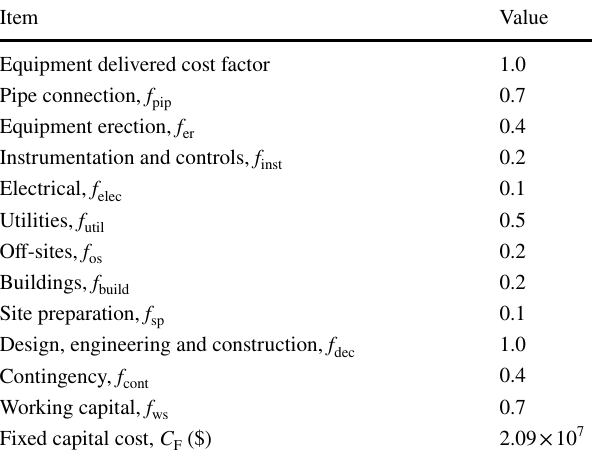
Table 4 Correction factors and the fixed capital